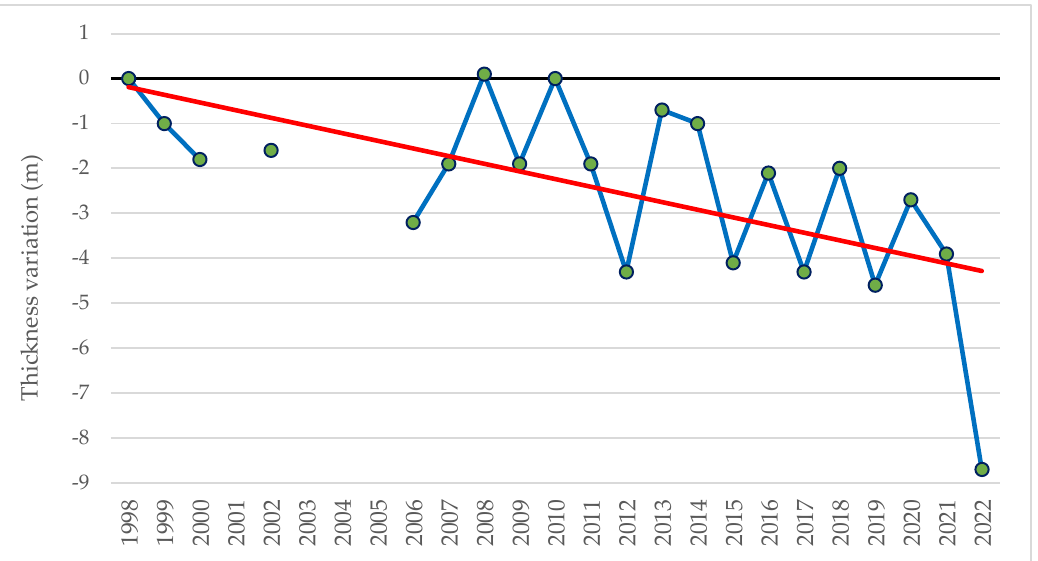
Figure 18. Evolution of the Infierno Glacier (Glacier lateral monitoring station). Period 1998 – 2022. Thickness variation, data in meters. References on position in 1998 and trend line (red). Years 2001 and 2002 to 2005: without data due to logistical problems or recent previous snowfalls that invalidated measurements.